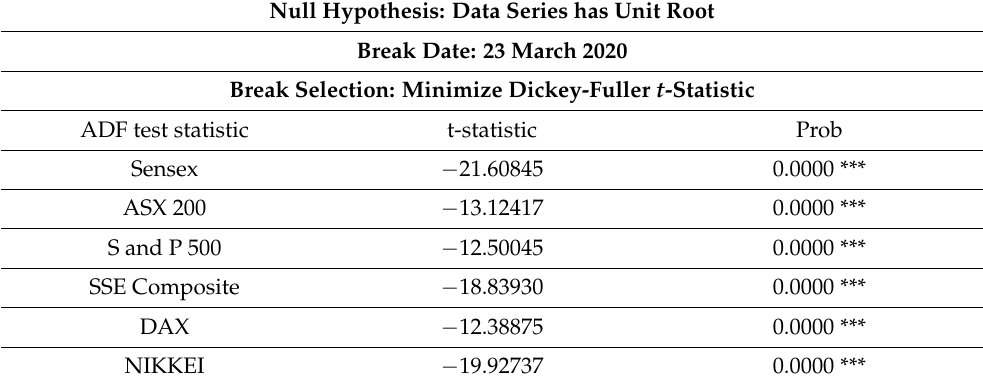
Table 3. Unit Root with Break Point